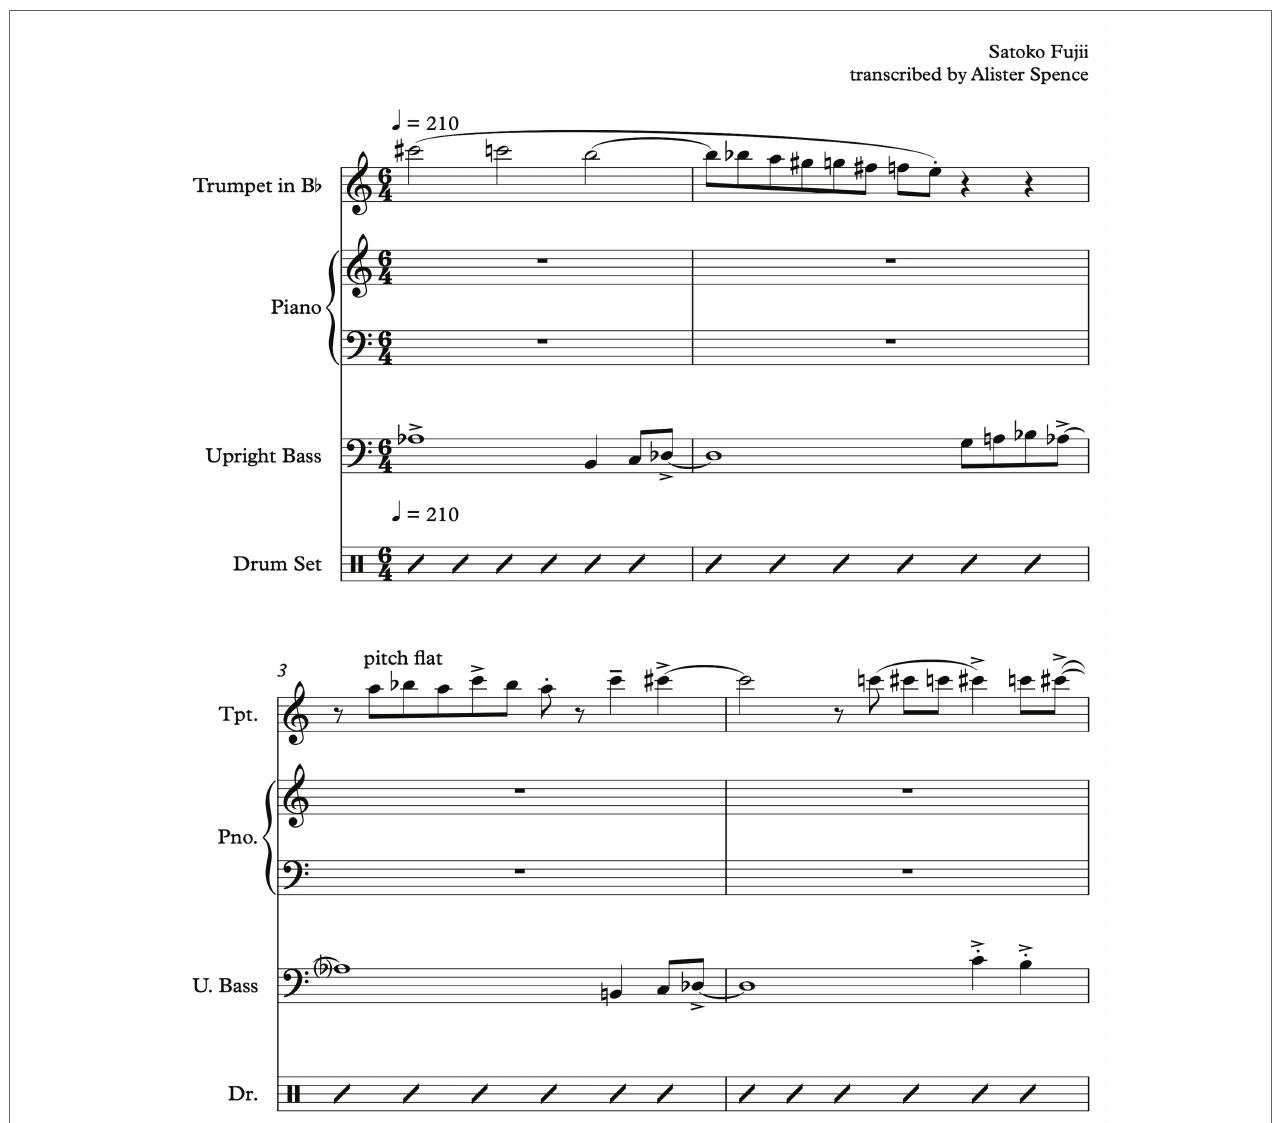
FIGURE 5 | “Spiral Staircase” trumpet improvisation and accompaniment excerpt (full